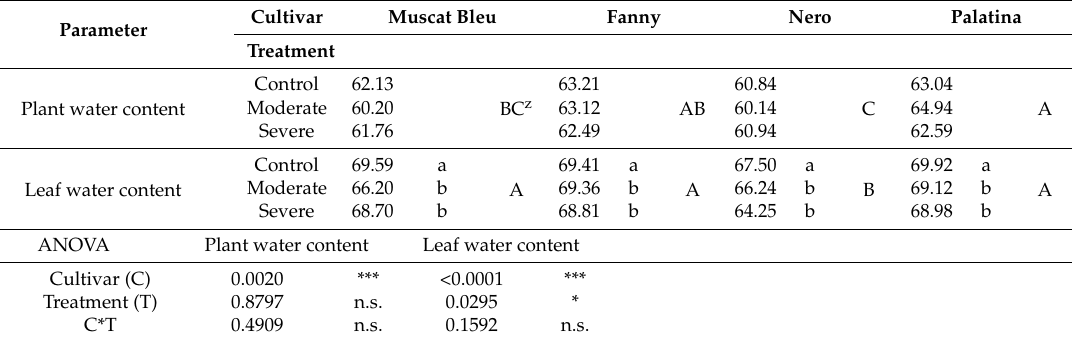
Table 6. Plant and leaf water content (absolute values) of four three-year-old table grape cultivars under three water deficit treatments at harvest in